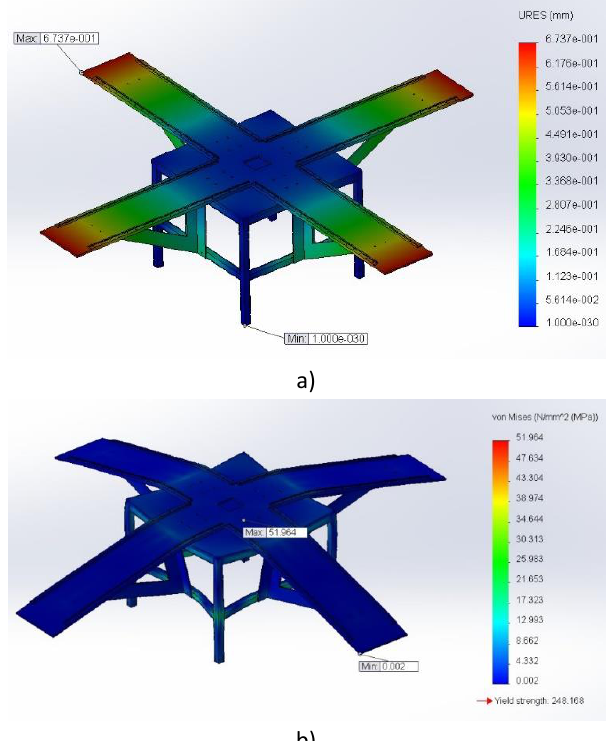
Figure 2. FEM analysis results: a) Deformation and b)